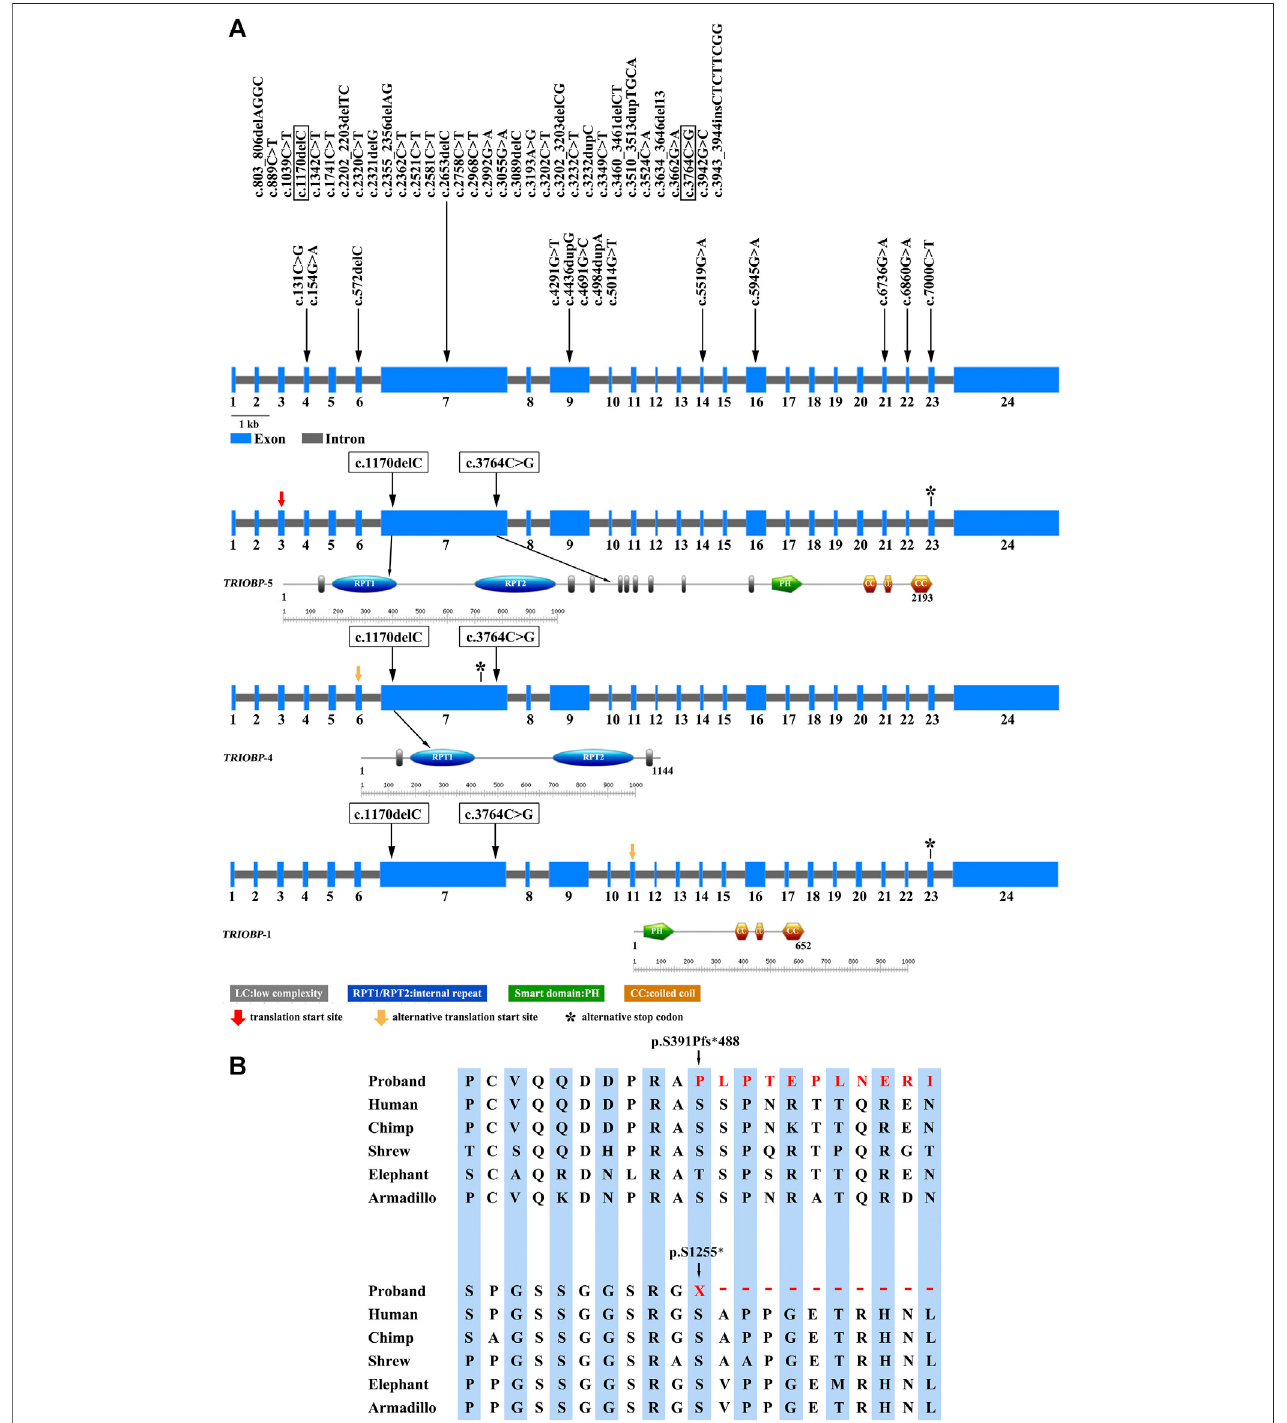
FIGURE 3 | (A) Variation spectrum and domain structure of the TRIOBP gene (NM_001039141.2). The variations identi fi ed in the proband in this study are represented in box. (B) Conserved amino acidsequences of TRIOBP (amino acid 391 and 1,255) and the predicted truncated TRIOBP caused by the variants identi fi ed in this proband.